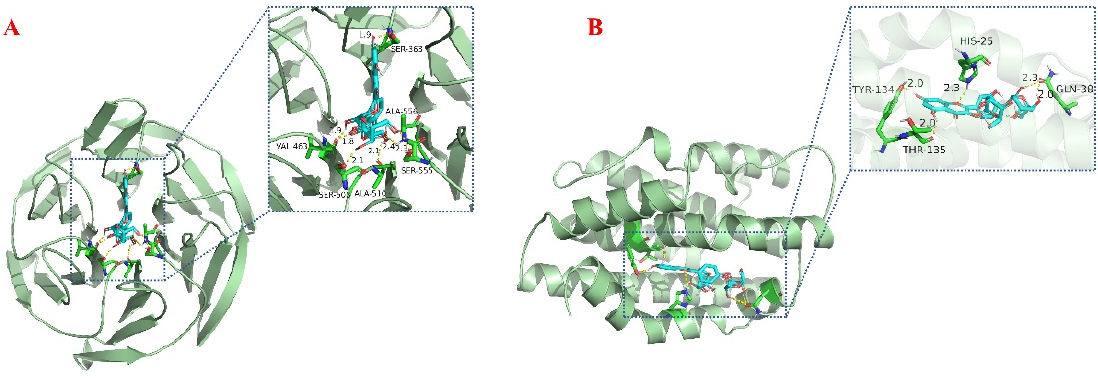
Figure 6. Molecular docking analysis of Nrf2 ( A ) and HO ‐ 1 ( B ) during binding to Fr3 ‐ 1.